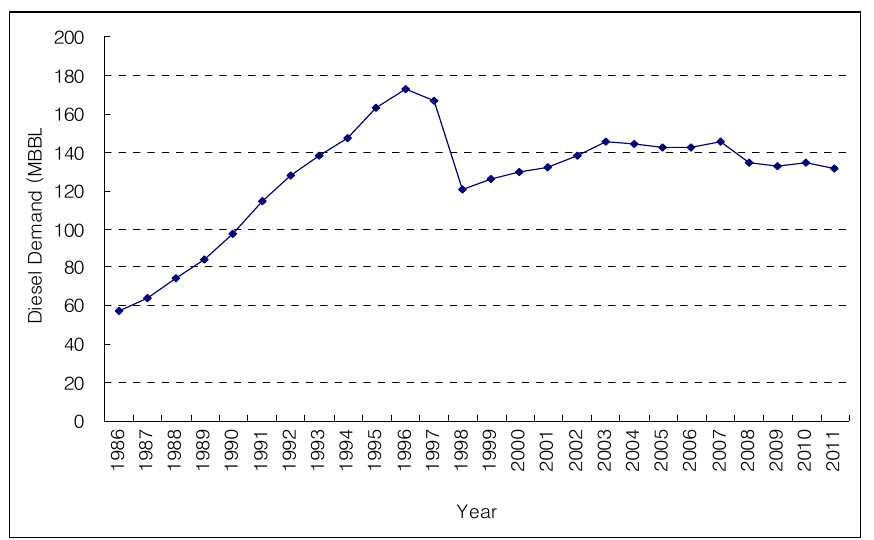
Figure 1. Diesel demand in